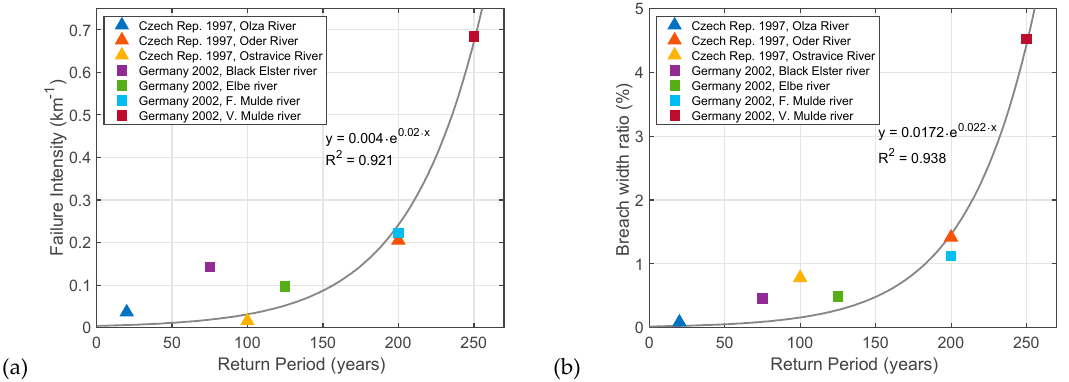
Figure 14. ( a ) Failure intensity (km − 1 ) and ( b ) Breach width ratio (-) along the rivers investigated during Germany, 2002 and Czech Republic, 1997 events.